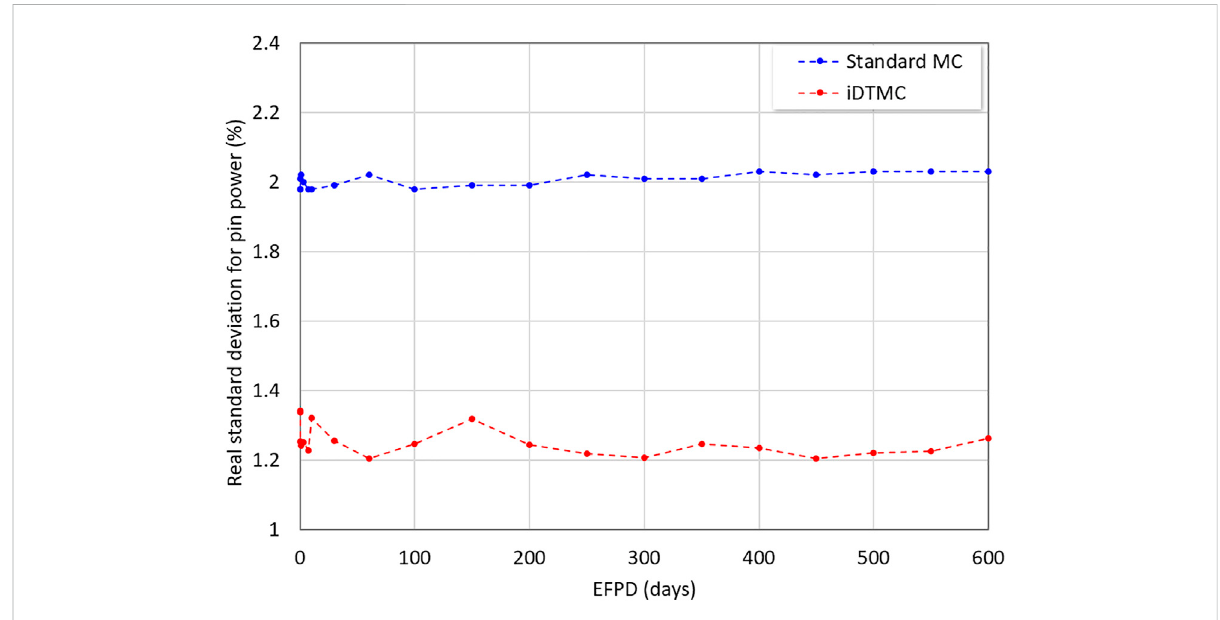
FIGURE 9 Average of real standard deviations for pin power (active cycle 10)